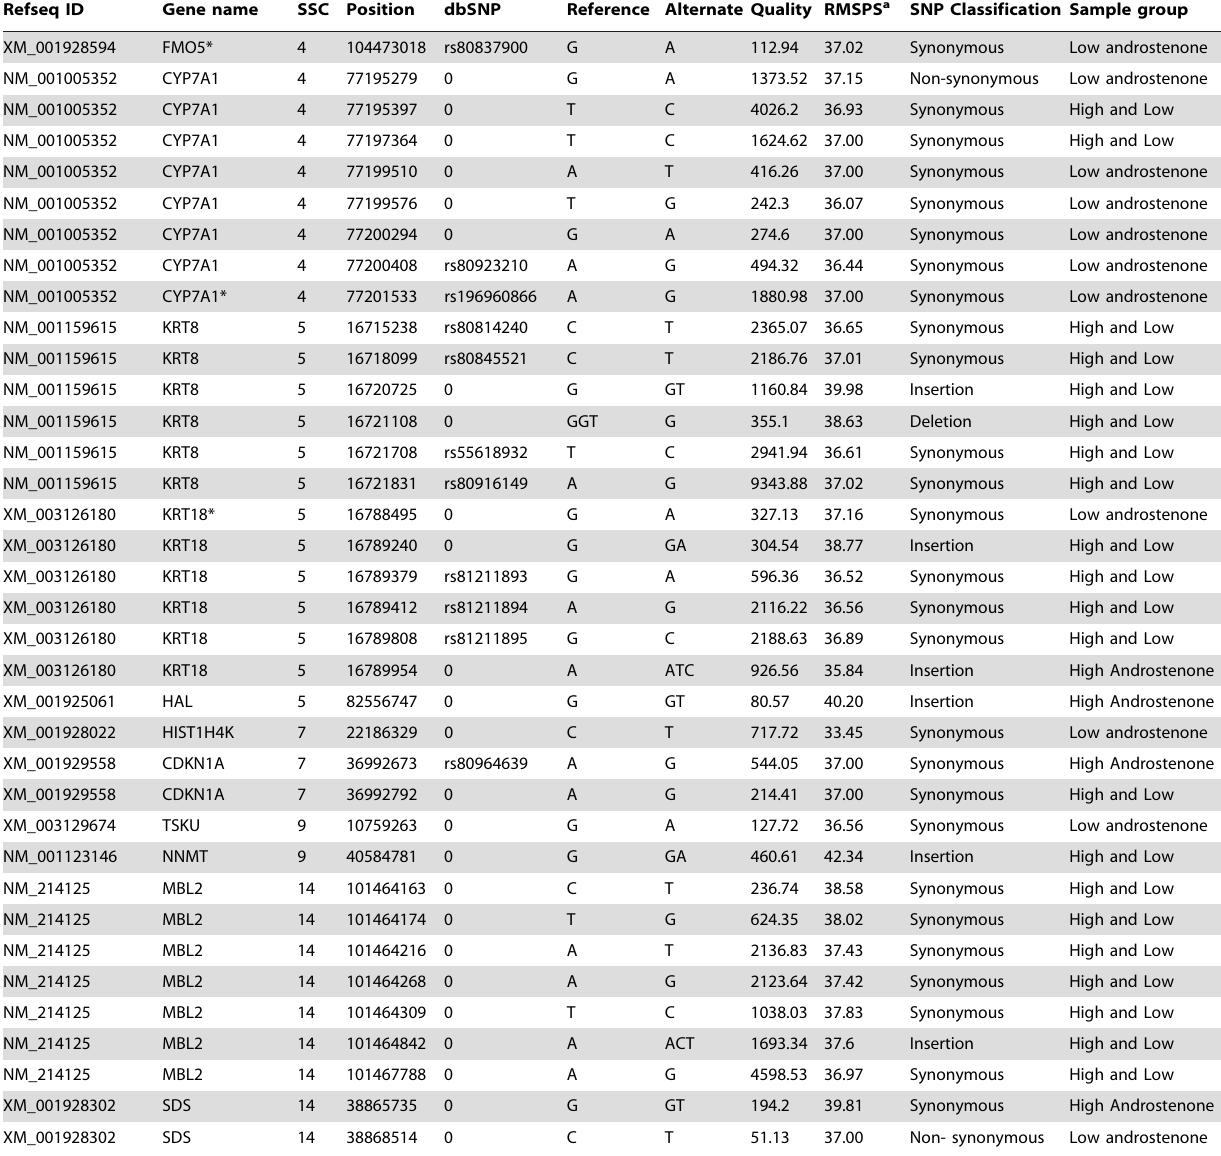
Table 8. Polymorphisms detected in liver